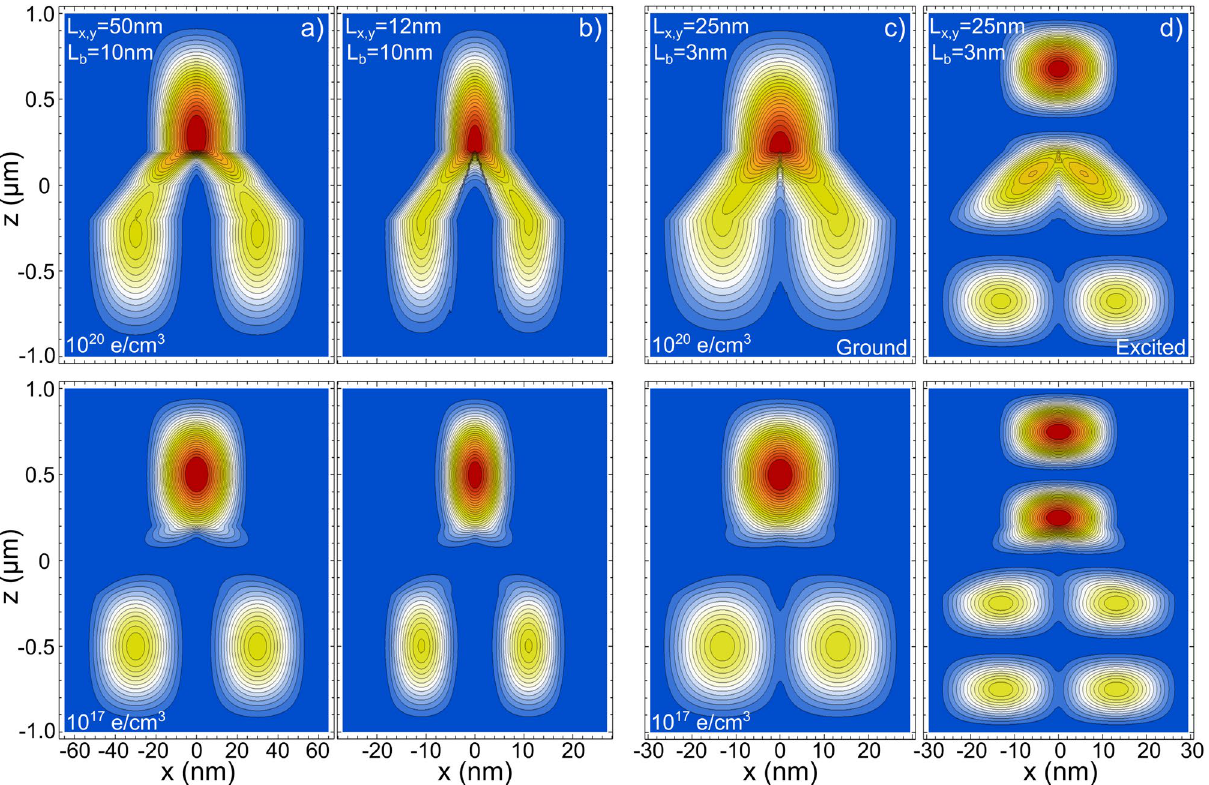
Figure 5. Electronic distributions from Y-Js of different sizes: column ( a ) L x , y = 50 nm, L b = 10 nm, and L z = 2 µ m; column ( b ) L x , y = 12 nm, L b = 10 nm, and L z = 2 µ m; columns ( c , d ) L x , y = 25 nm, L b = 3 nm, and L z = 2 µ m. Only in column ( c ) are presented excited states. The top row corresponds to a density of 1 × 10 20 electrons/ cm 3 and the bottom row to a density of 1 × 10 17 electrons/ cm 3